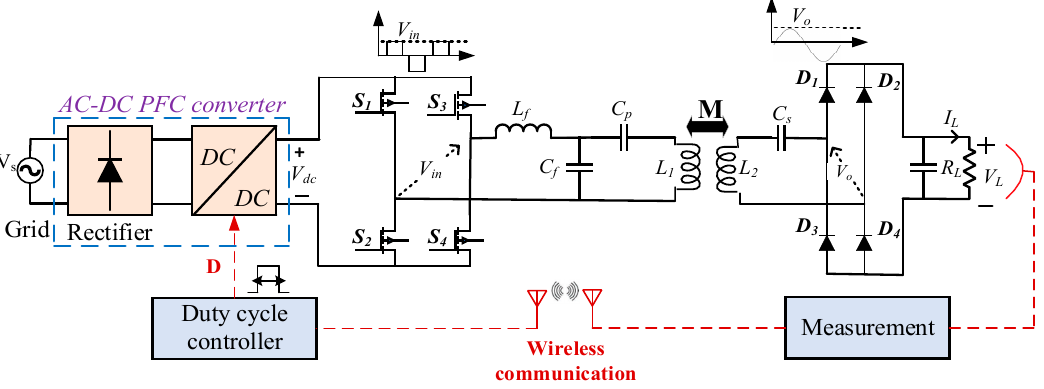
Figure 23. Transmitter-side dc-link voltage control for a WPT system.